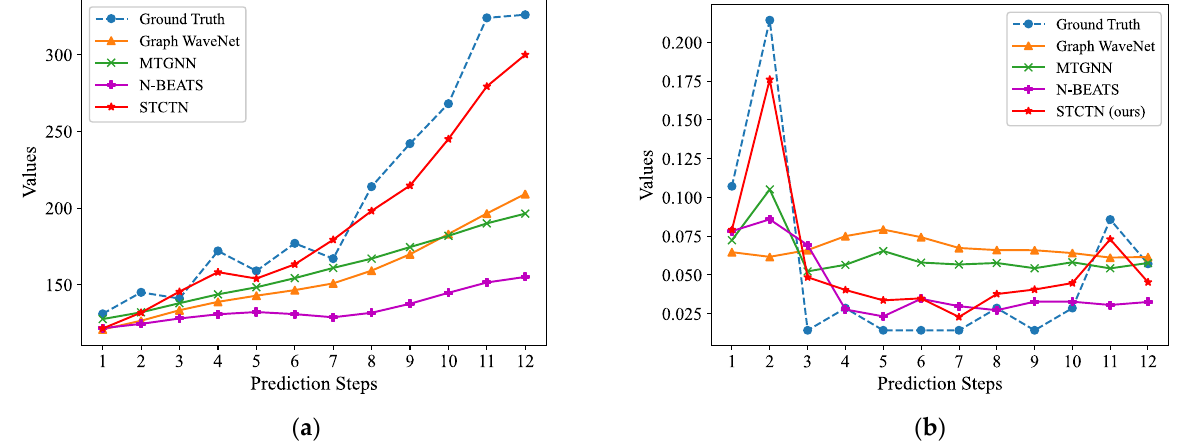
Figure 4. The forecasting results of 12 steps on different datasets. ( a ) PEMS08; ( b ) Electricity.